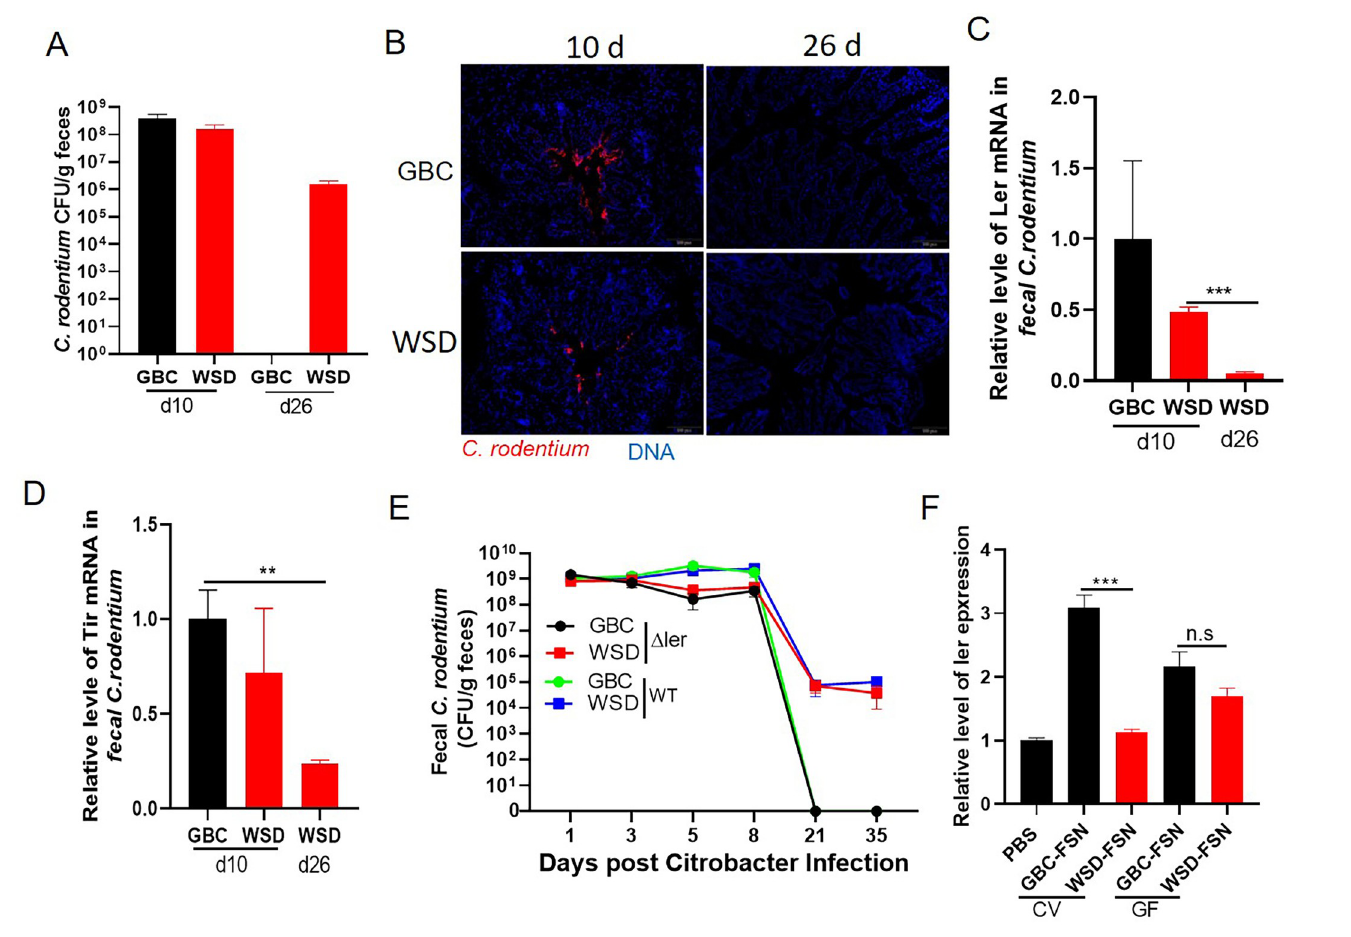
Fig 3. WSD feeding resulted in reduced C . rodentium virulence gene expression. A . Quantification of fecal C . rodentium at the indicated days post-inoculation. B . Immunofluorescent staining of C . rodentium in colon tissue at the indicated days post-inoculation. C-D . The relative expression level of C . rodentium virulence genes measured by qRT-PCR. E . GBC and WSD fed mice were orally gavaged with kanamycin and, 16h later, inoculated with WT and Δ ler C . rodentium. Fecal C . rodentium CFU was monitored. F. Ler expression of C . rodentium grown in minimal media supplemented with fecal supernatant (FSN) from conventional (CV) or germ-free (GF) mice as indicated by a luminescent ler reporter strain. Results were expressed as the relative fold changes of luminescence by normalizing to CFU of ler-lux C . rodentium in the same samples. Data are the means +/- SEM (n = 3–5 per group) and representative of 2 separate experiments.